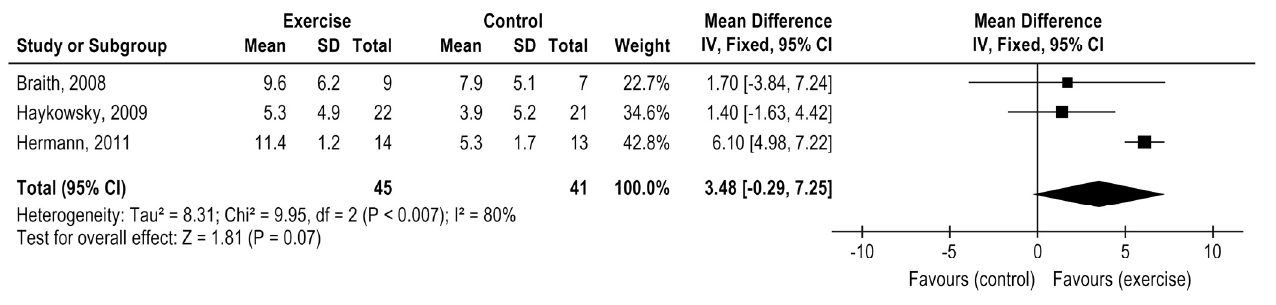
Figure 6. Impact of exercise training on flow-mediated dilation in HTx.